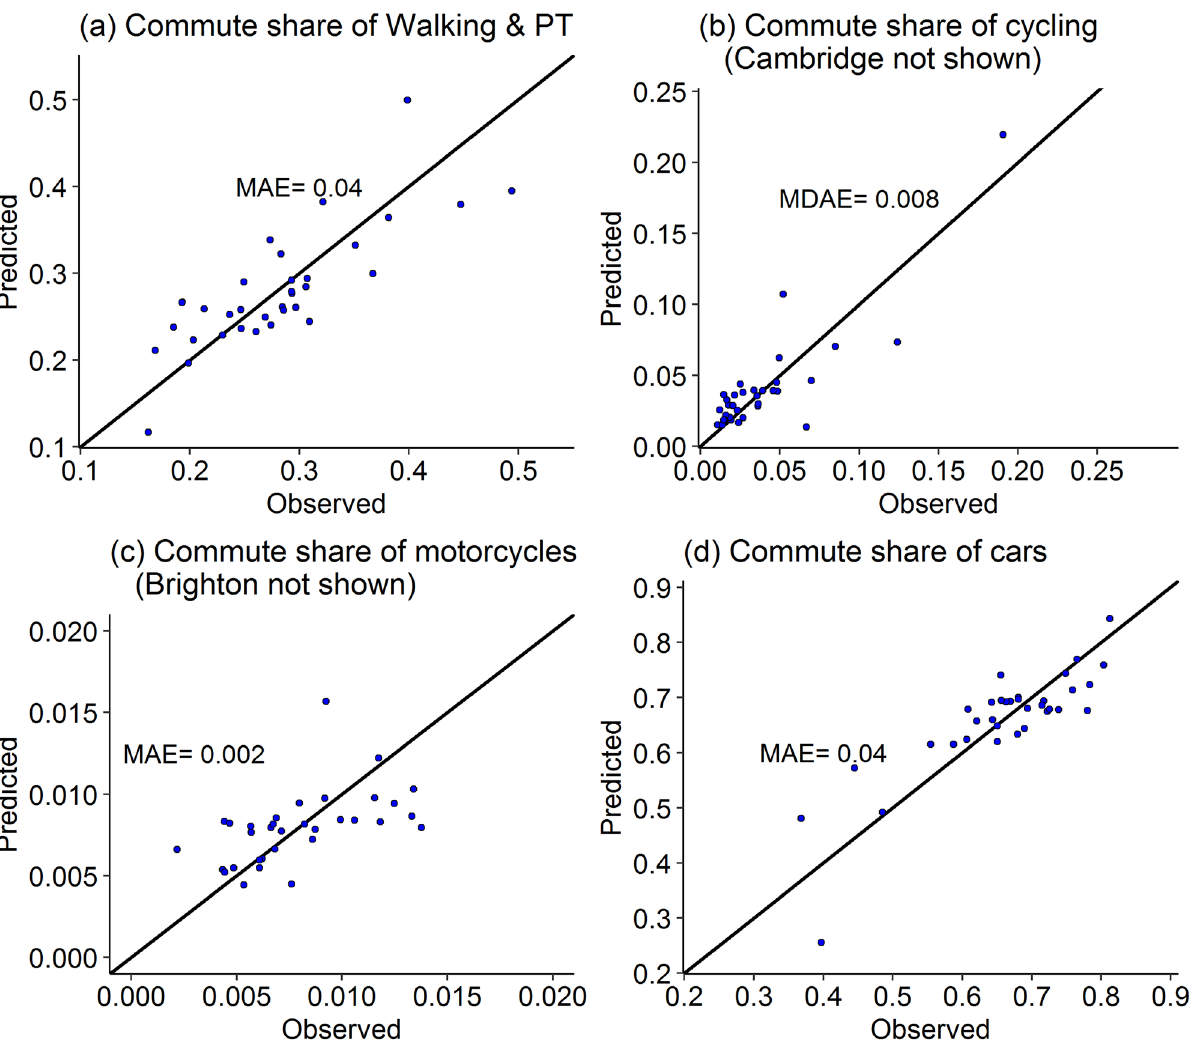
Fig 5. Observed and predicted mode shares using LOOCV with mean absolute error (MAE) and median absolute error (MDAE) for cycling measures (a: Model 1; b: Model 2; c: Model 3; d: Model 4).